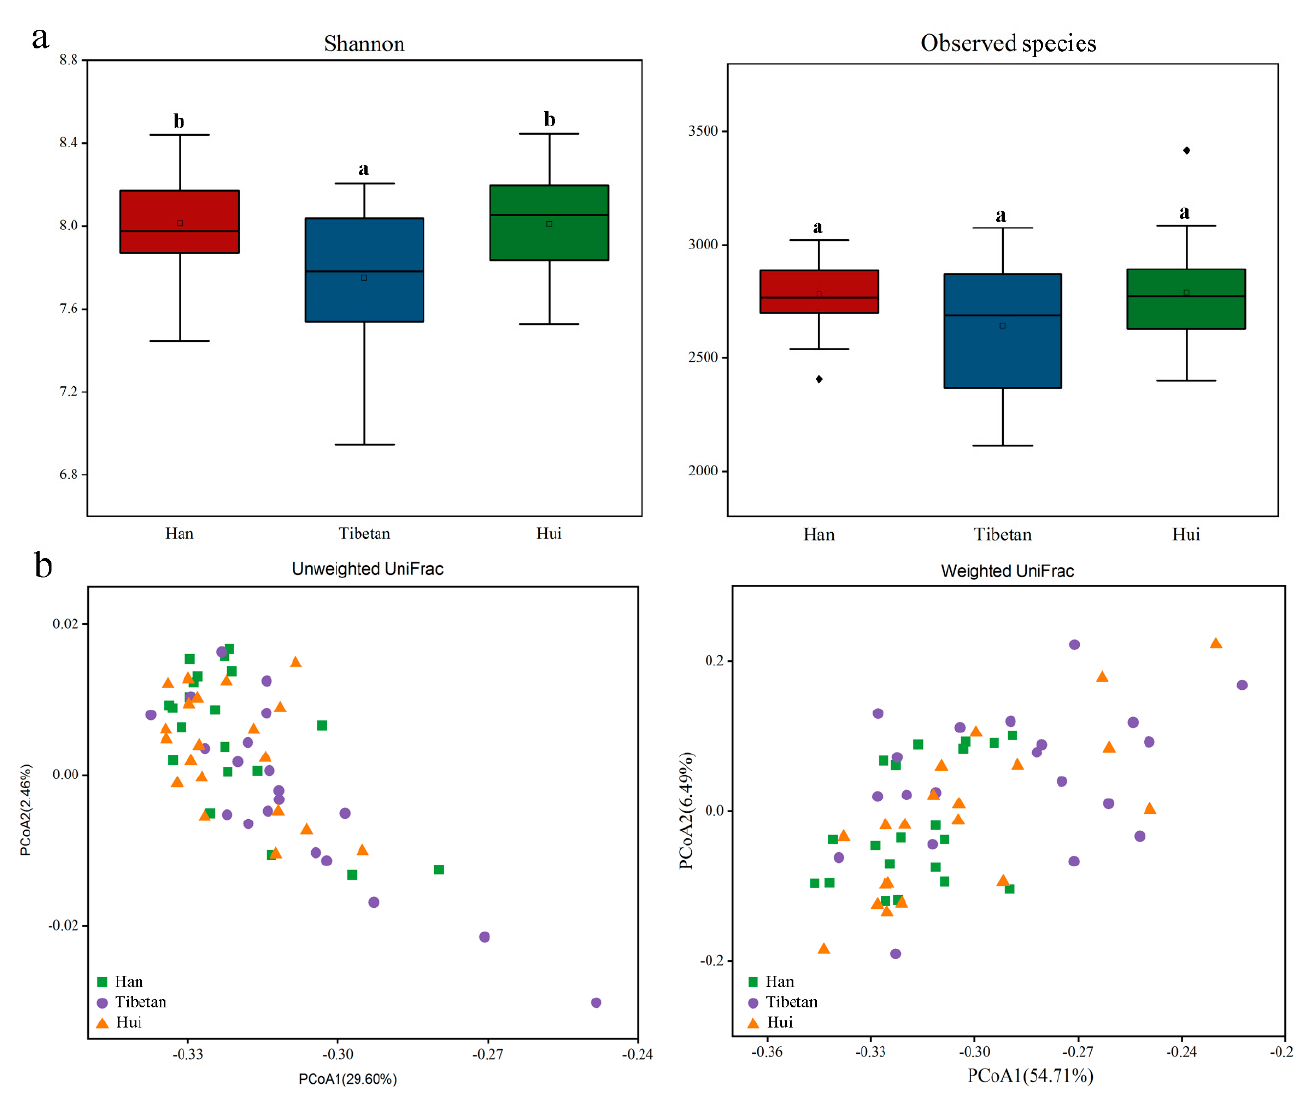
Figure 2. ( a ) Alpha diversity indexes (Shannon diversity and observed species) of the three ethnic groups. Different lower-case letters indicate significant differences between the groups. ( b ) PCoA based on unweighted and weighted UniFrac distances comparing the bacterial community among the three ethnic groups.